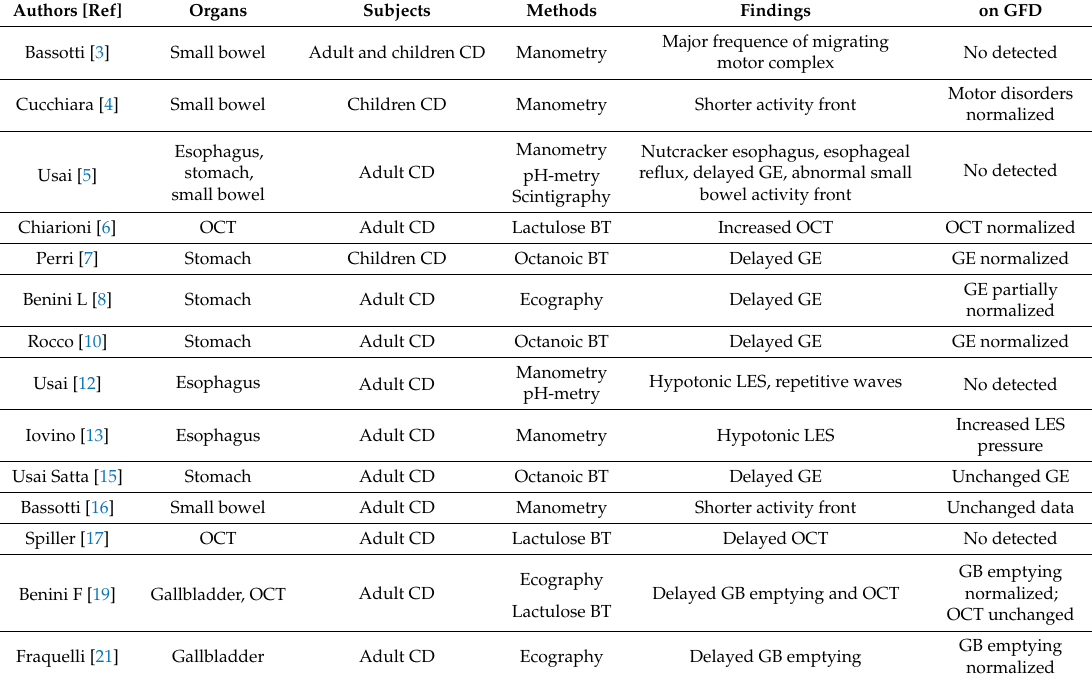
Table 1 summarizes gut motility results in untreated and treated CD patients. Table 1. Summary of more significant studies on gut motility in celiac disease